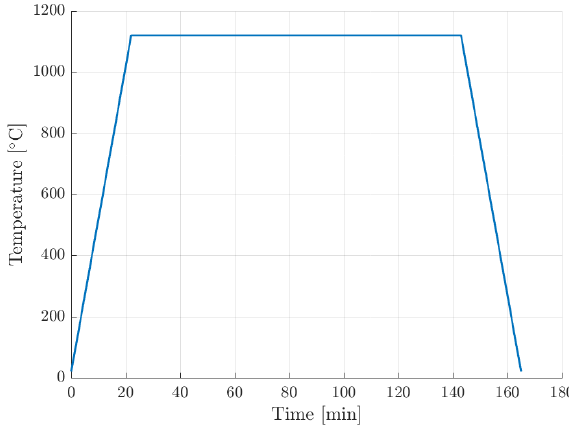
Figure 2. Sintering profile for uniform temperature field simulation To determine the model sensitivity to temperature distribution, two groups of simulations have been